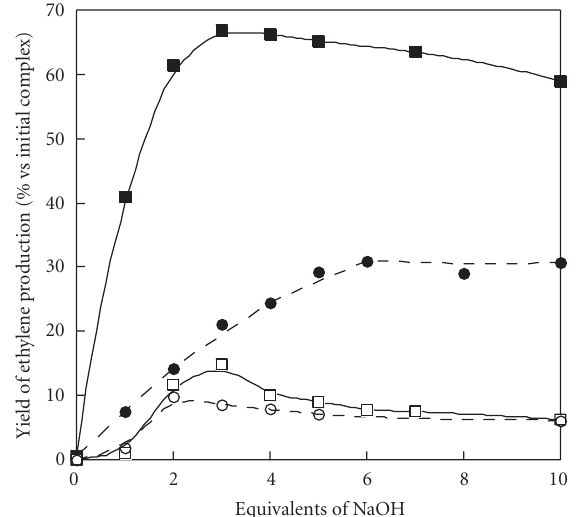
Figure 4: Ethylene production by complex 1 (1mM) in the pres- ence of 10 equivalents of H 2 O 2 as a function of NaOH added in wa- ter (- - • - -) or in methanol (— (cid:2) —) and by a mixture of (CuClO 4 · 6H 2 O + ACC) either in water (- - (cid:5) - -) or in methanol (— (cid:3)